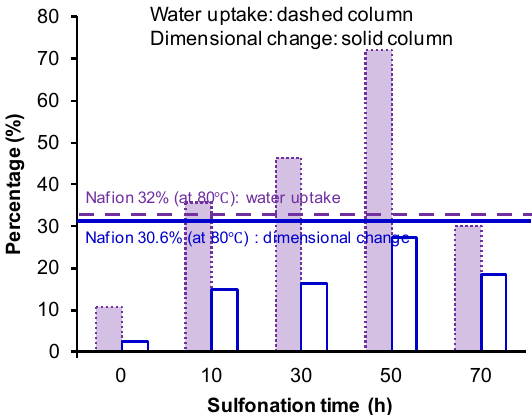
Figure 6. Water uptake and dimensional change of s - OPBI as a function of the sulfonation